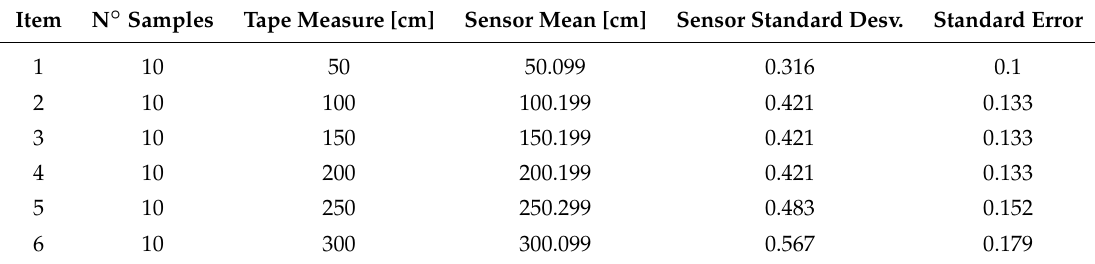
Table 1. Measurements taken on land